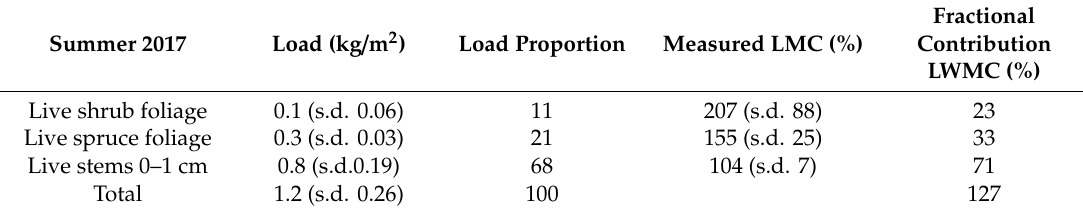
Table A3. Summer 2017 burn Live Moisture content estimates based on fuel loading in the sampled categories. * sampled quantities have estimated standard deviation in parenthesis.